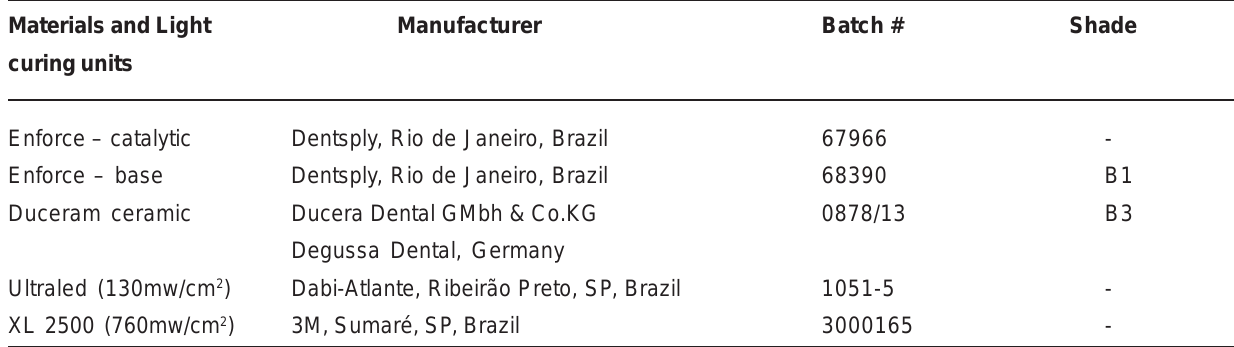
Table 1- Materials used in this study, manufacturer, batch number and shade of the